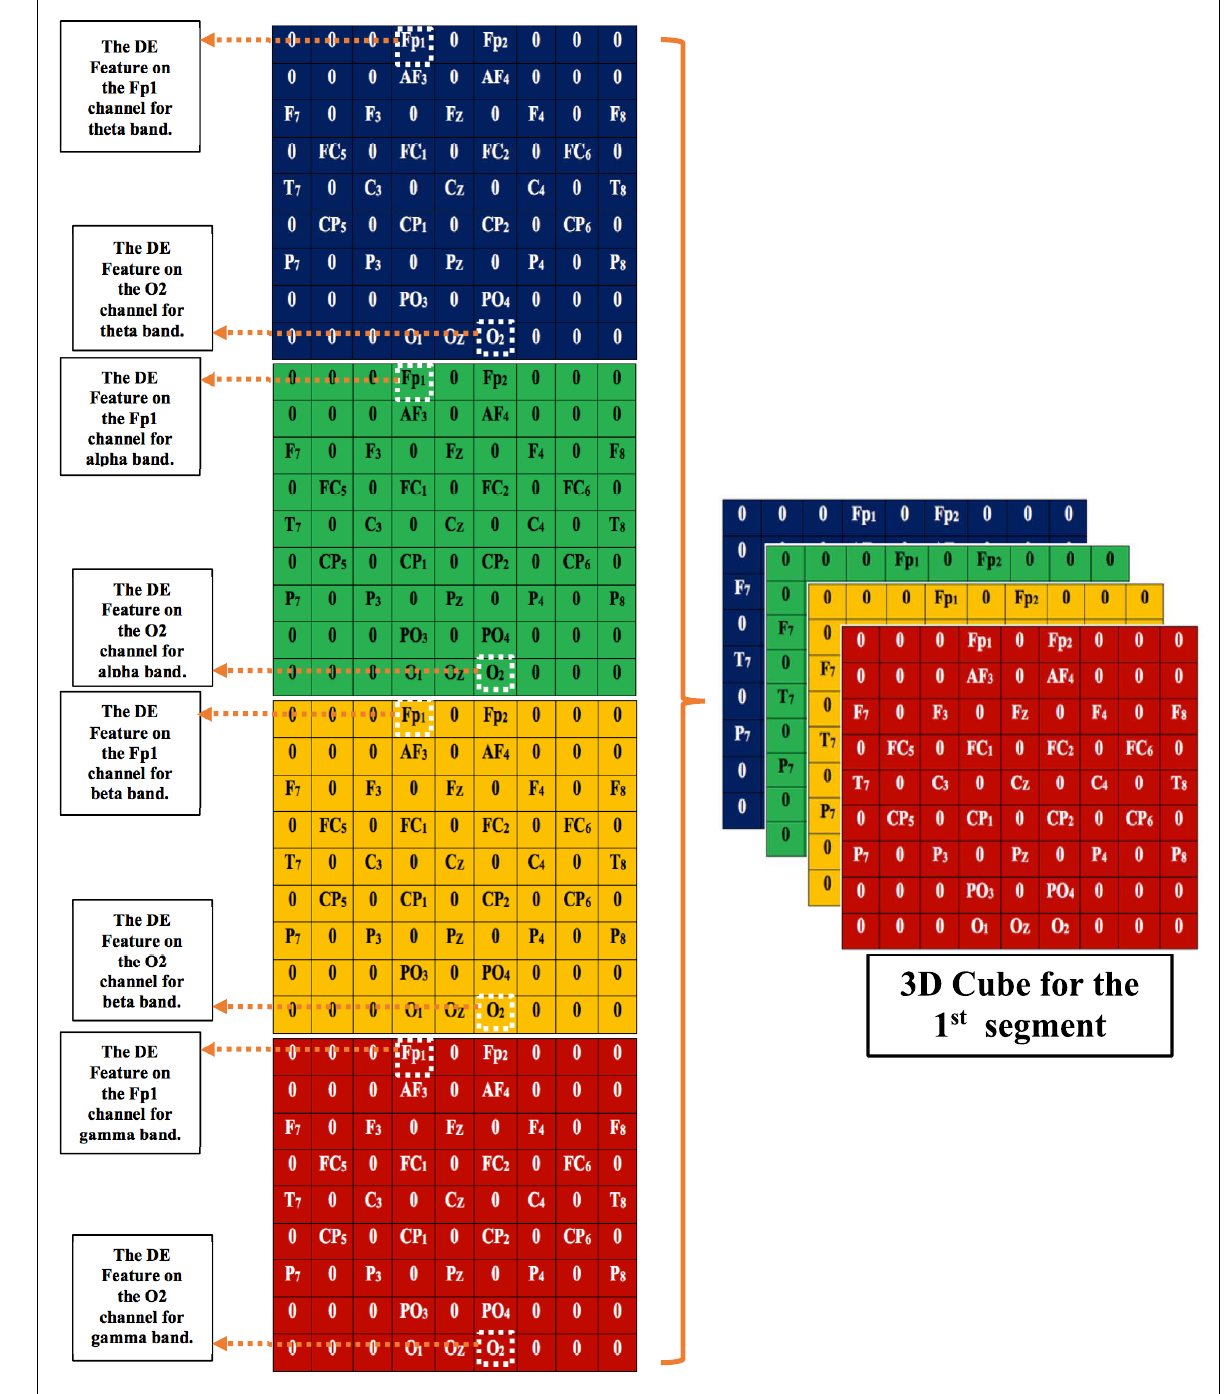
Figure 6. The feature representation using 3D Cube in one segment